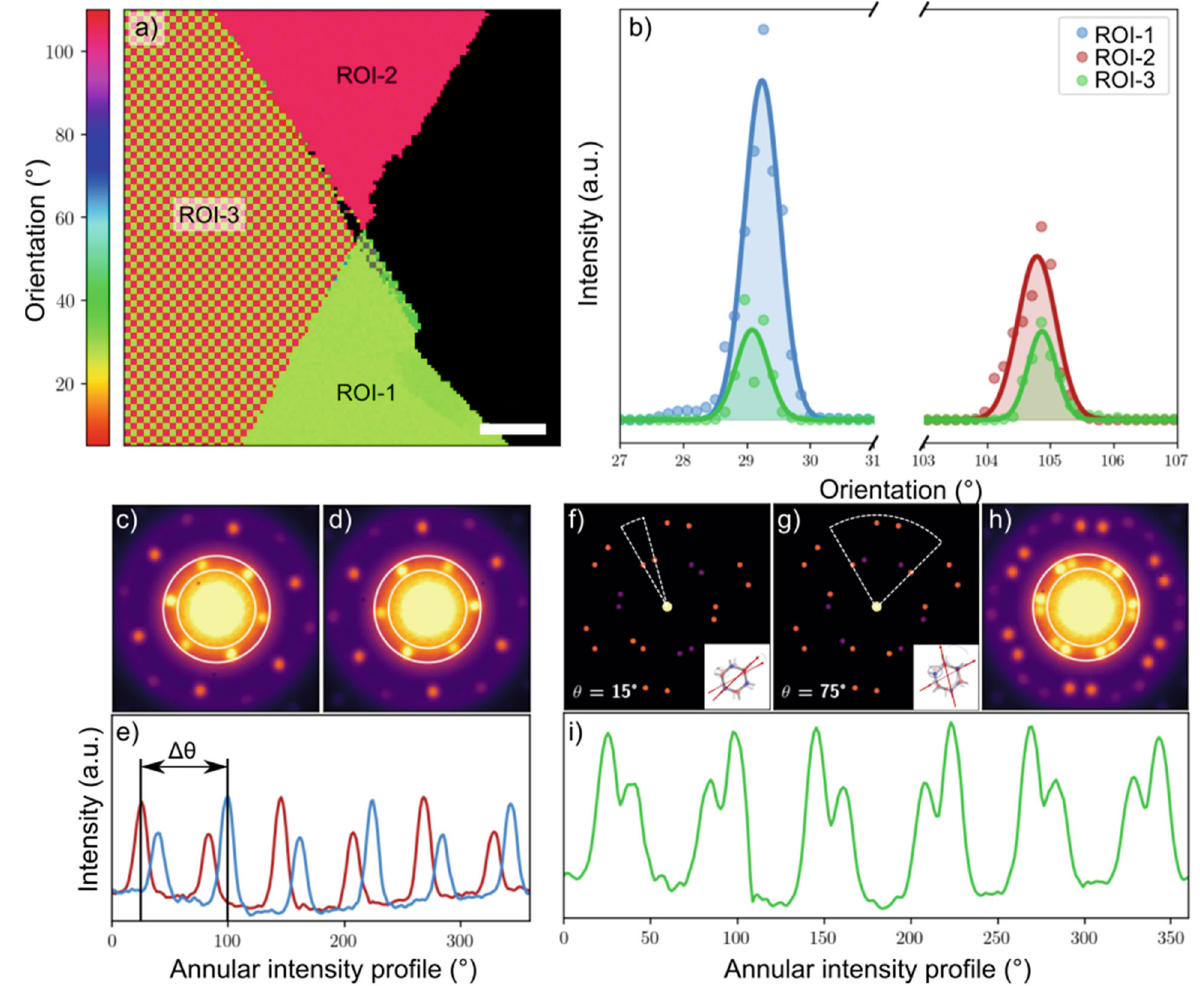
Fig. 6 Twist-angle calculation. a The relative color-coded direction map of a bilayer region selected in Fig. 6b. b Histogram of the relative direction of the monolayers and the bilayer indicating that the two layers are stacked upon each other since its direction in the bilayer correspond to both monolayers. c , d The diffraction pattern averaged over 400 probe position for the fi rst and second monolayer. e The annular intensity pro fi le of the fi rst order spots where a modulation of intensity is observed. f , g The simulated diffraction patterns of the WS 2 bilayer when the twist-angle is 15.5(°) and 75.5(°) (60(°) + 15.5(°)). h Experimental diffraction of the bilayer region, averaged over 400 probe positions. i The annular intensity pro fi le of the fi rst order spots of experimental diffraction where the intensity modulation of the two layers is reversed indicating the twist angle of 75.5(°) instead of